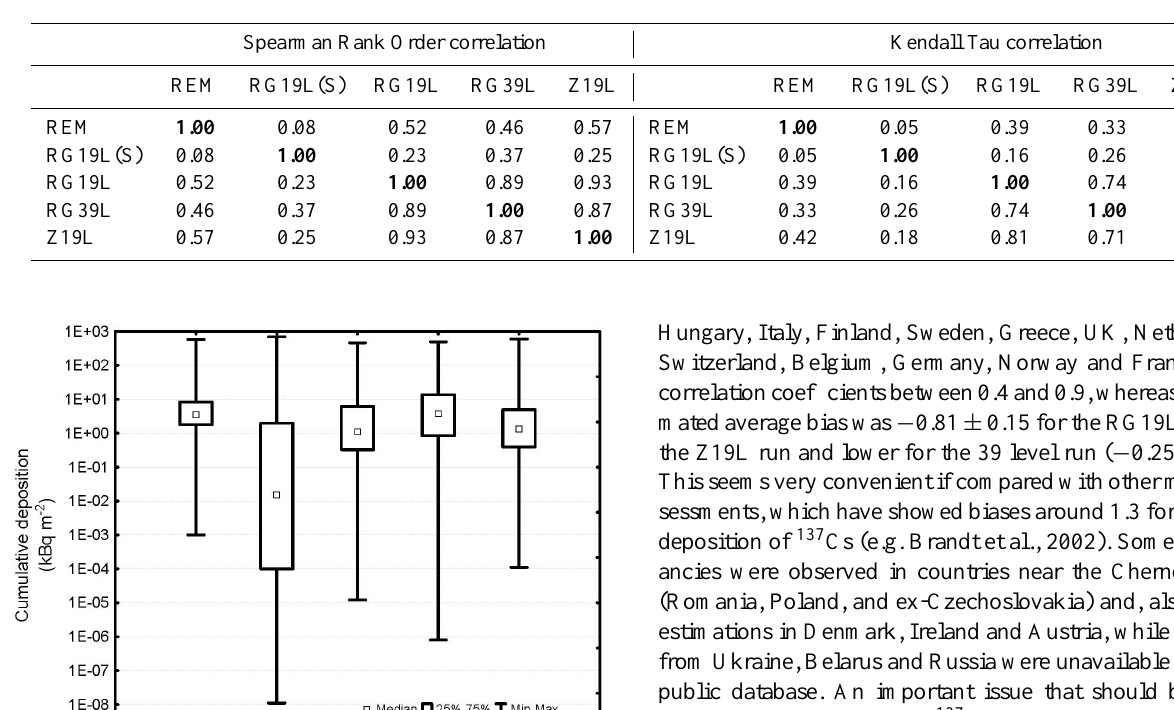
Table 4. Comparison of the total cumulative deposition of 137 Cs from the Chernobyl accident between the REM database and the different model versions used (RG19L(S), RG19L, RG39L and Z19L). Spearman Rank Order and Kendall Tau correlations ( R 2 ) between the datasets ( N = 4266) for 95% confidence level ( p < 0.05).